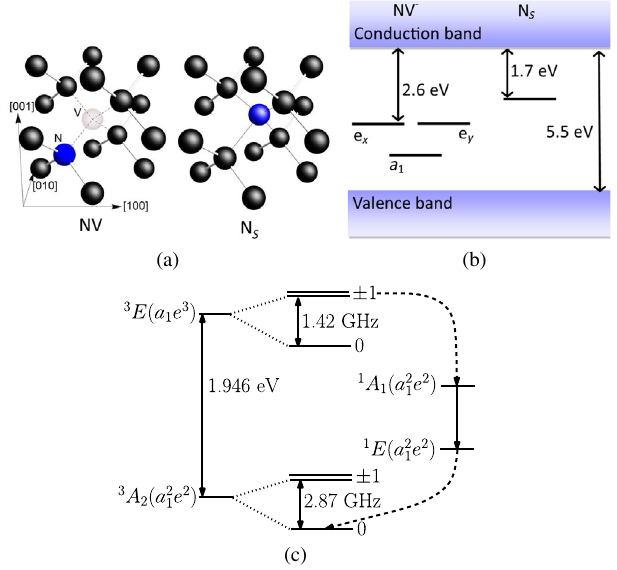
FIG. 1. (a) Diagrams of the NVand N centers that depict carbon S (black) and nitrogen (blue) atoms and the vacancy (transparent). (b) Electronic band structure diagram depicting the defect levels of the NV ( a 1 , e , e ) and N centers. The diamond indirect band gap x y S and defect photoionization energies are as indicated [42,43]. (c) Electronic structure of the NV − center depicting the electronic levels (with corresponding electronic configurations in paren- theses) and fine structure states (denoted by electronic spin projection) [1]. The visiblezero-phonon line energy and the zero-field fine-structure splittings of the triplet levels are as indicated. Solid arrows represent optical or spin transitions, whereas dashed arrows represent the spin-selective nonradiative ISCs that lead to optical spin polarization and